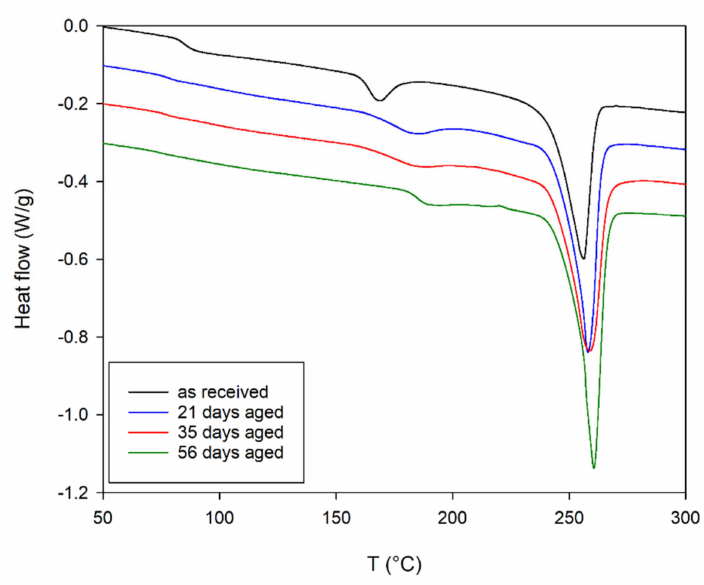
Figure 2. DSC thermogram of as-received and unaged PET, curves have been shifted in relation to each other in order to better visualize the